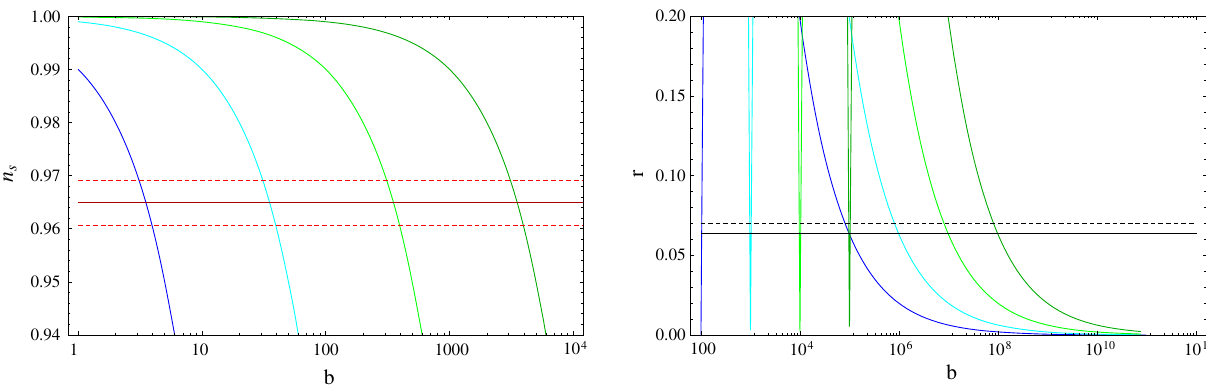
Fig. 2 The spectral index n S on the left and the tensor-to-scalar ratio r on the right for the exponential function h (χ) = γ e b χ in the case of a de Sitter evolution, with respect to b , for N = 50, γ = 1 and μ = 10 12 s − 1 . The color conventions are the same as in Fig.